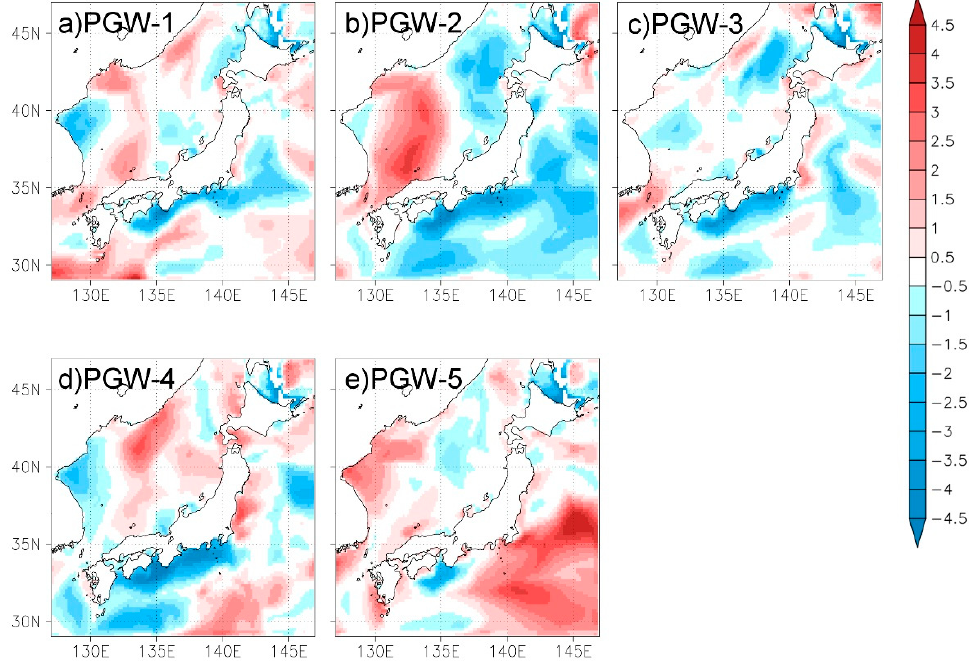
Figure 7. ( a )–( e ) Future variations of H s_max in each PGW simulation. Unit of color bar is m.